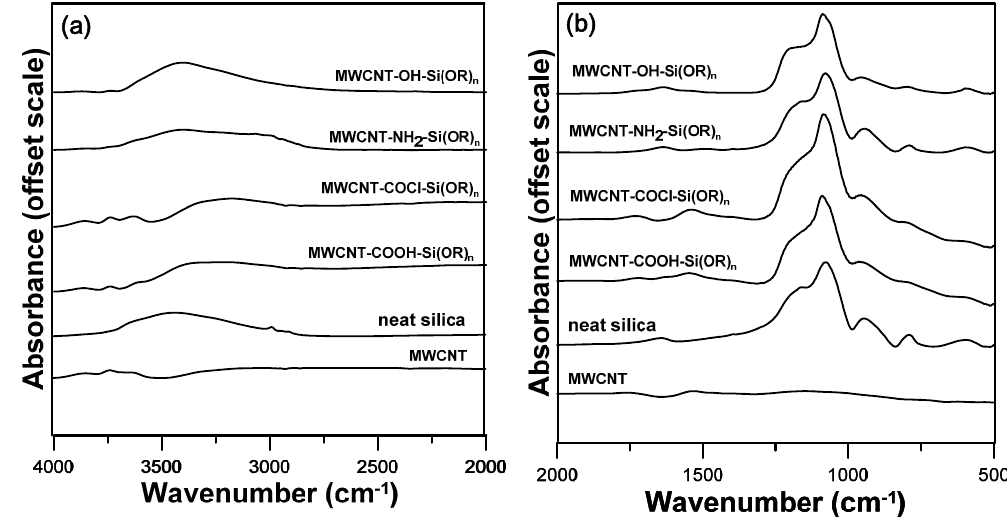
Figure 2. FT-IR spectra of MWCNT-grafted silica nanohybrids: ( a ) the IR region between 2000 and 4000 cm − 1 and ( b ) the IR region between 500 and 2000 cm − 1 .